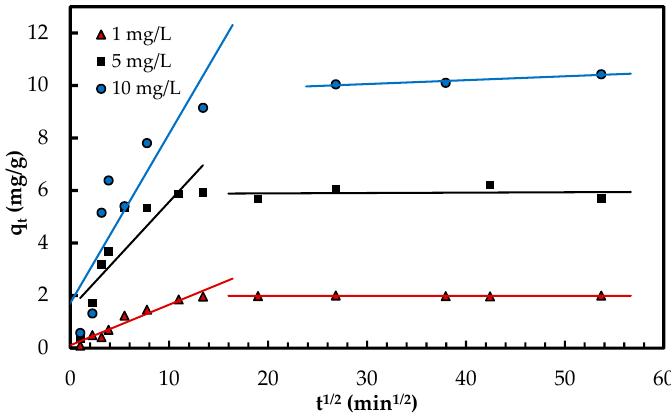
Figure 8. Phosphate adsorption steps onto Zn(II)–CTS bio-sorbent determined with the intra-particle diffusion model.